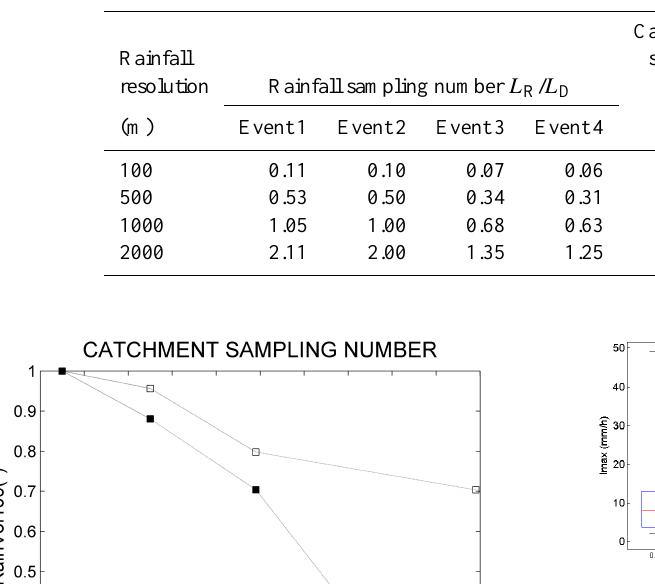
Table 4. Dimensionless parameters values derived from scale length values, for the four different rainfall resolutions used in the study. Values presented for runoff sampling and sewer sampling numbers, represent value ranges for the 10 subcatchments (outlined in Fig. 4).